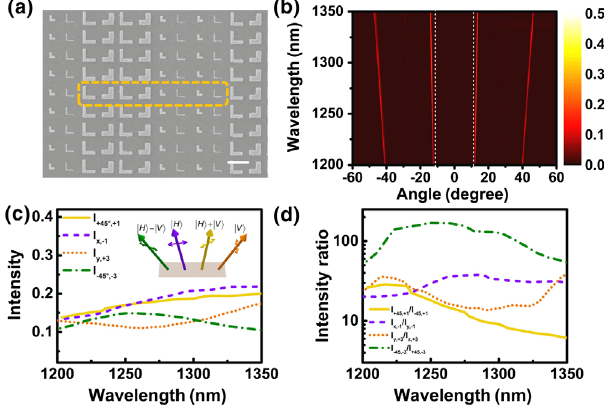
FIG. 4. (a) SEM micrograph of the fabricated metasurface as designed in Fig. 3(b). The unit cell is marked by the dashed-line box. The bar represents 1 μ m. (b) Measured angle-resolved diffraction spectra. The four bright lines represent the diffracted beams measured at a different wavelength at different diffraction angles. The color bar stands for the intensity. (c) Normalized beam intensity of four diffracted beams. Note that I pol ; num represents the intensity of “ num-th ” order, with “ pol ” polariza- tion. In the wavelength range of 1200 – 1350 nm, the normalized intensity of each diffraction beam is higher than 10%. At 1300 nm, the intensity of each diffraction order is higher than 12%, and the total normalized diffraction intensity reaches 65%.